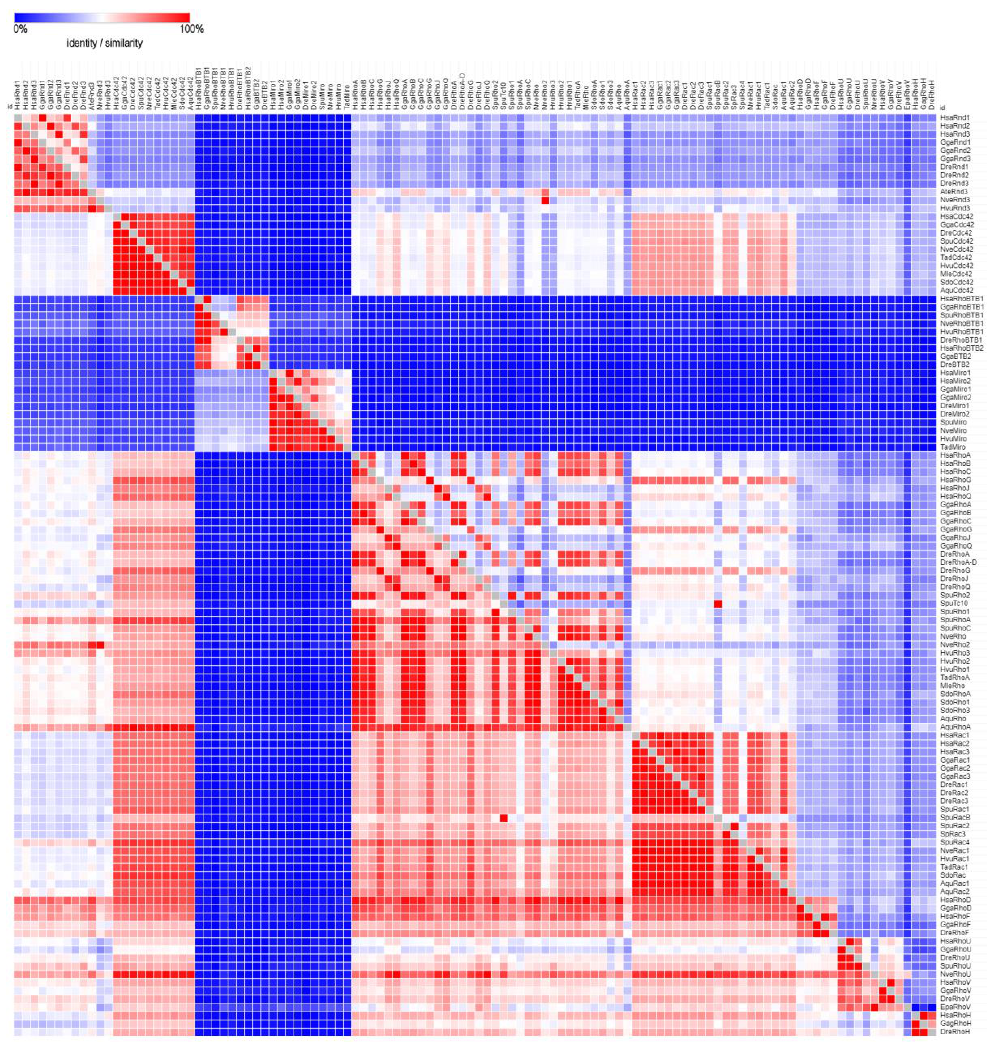
Figure 4. The summarized amino acid similarity of metazoan Rho proteins (MatGAT2.01 (Scoring Matrix BLOSUM62)) is presented using a heat map (red color indicates a high and blue a low percentage of sequence identity / similarity) generated by Morpheus (https: // software.broadinstitute.org / morpheus). The detailed accession numbers of the protein sequences are shown in Table